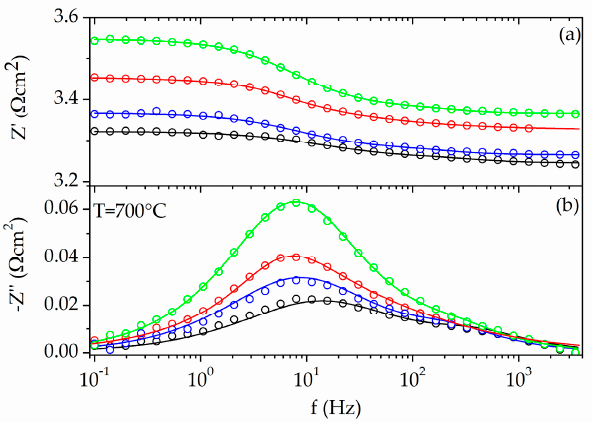
Figure 3. Real ( a ) and imaginary ( b ) part of impedance spectra of BSCF at 700 ◦ C and for various cathodic bias levels: black = 0 V, blue = − 0.05 V, red = − 0.1 V and green = − 0.2 V. Symbols represent experimental data, lines represent the best fit of data obtained by equivalent circuit described in the text.